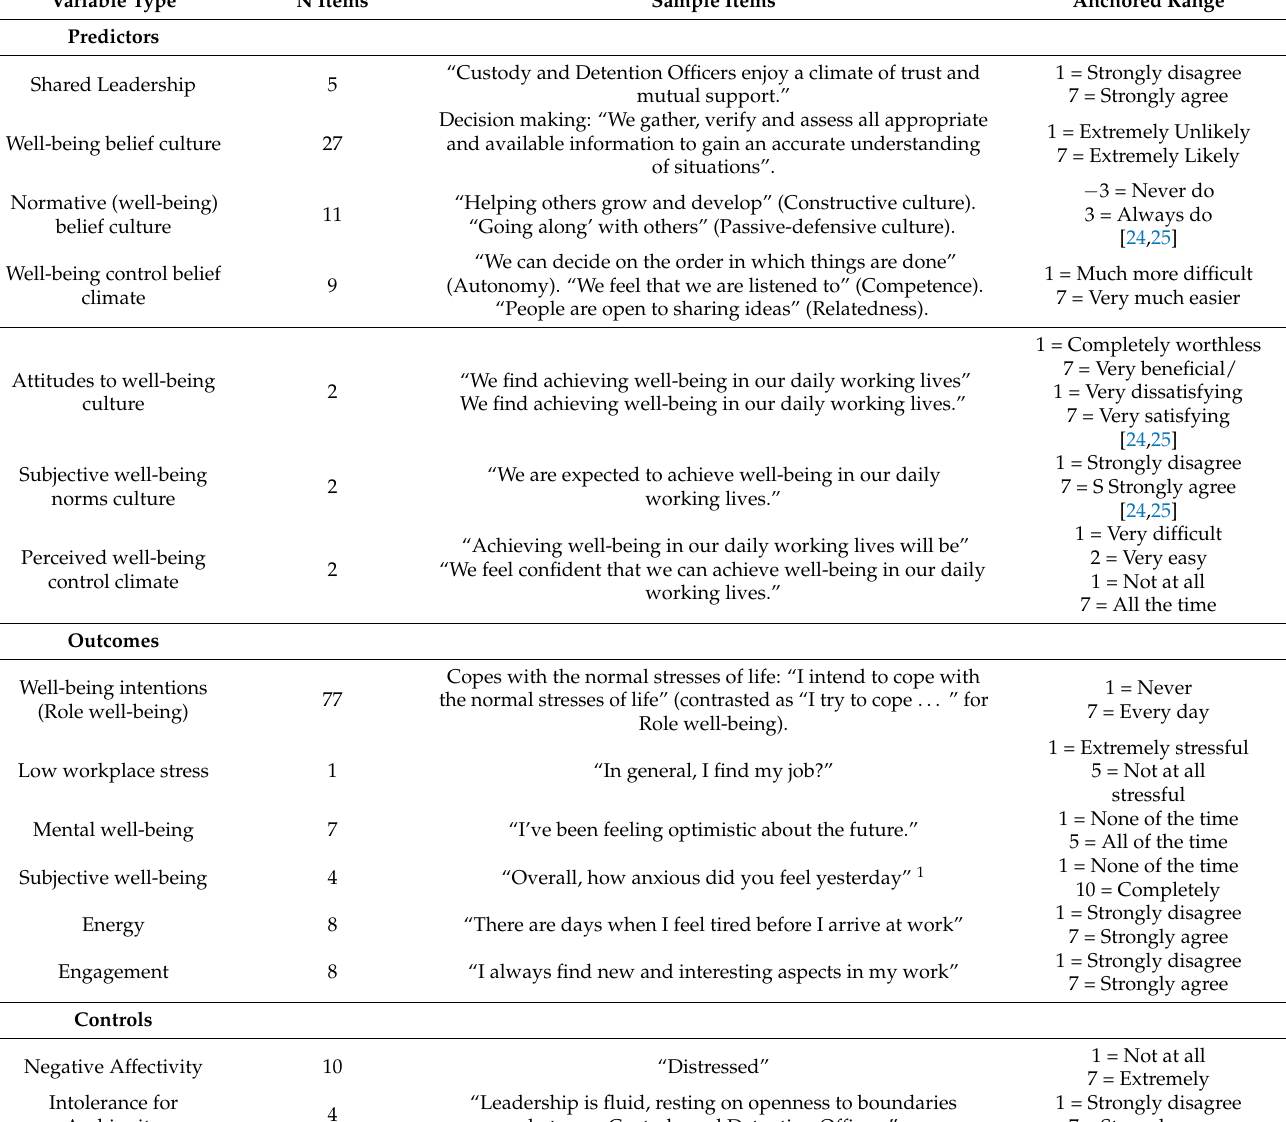
Table A1. Sample items of predictor, outcome, and control